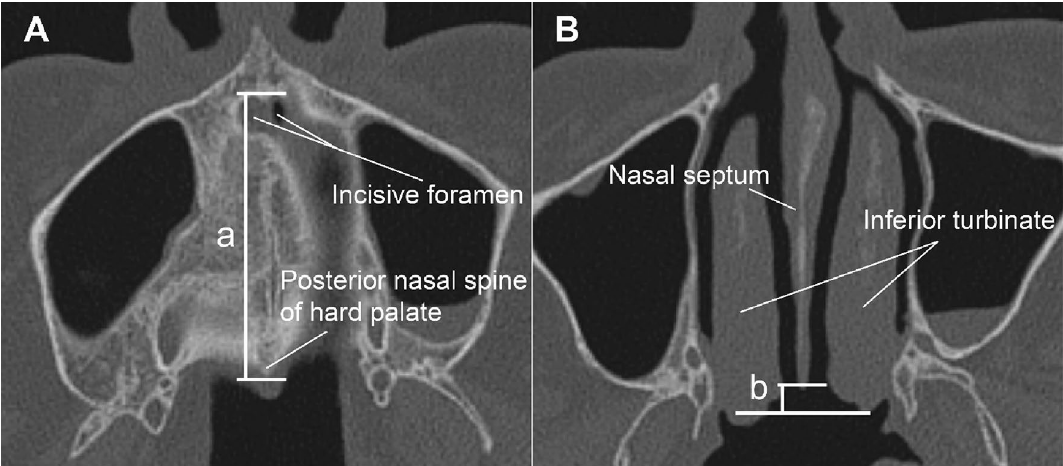
Figure 4. Measurement of vomer-maxilla fusion length (a) and vomer deformity (b) on computed tomography images of patients with a normal hard palate and vomer. ( A ) Vomer-maxilla fusion length is defined as the length from the incisive foramen to the posterior nasal spine of the hard palate. ( B ) Vomer deformity is defined when the posterior edge of the septum is ˃ 5 mm shorter than the shorter side of the posterior end of the inferior turbinate (b > 5